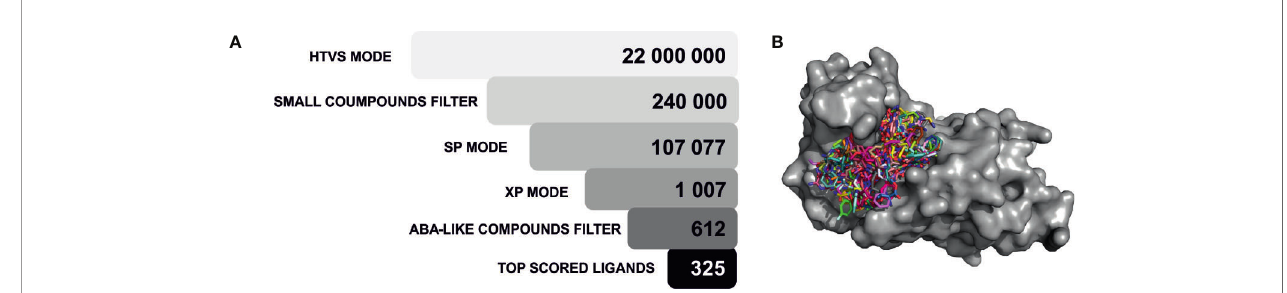
FIGURE 4 | Virtual screening procedure. (A) The 325 top-ranked compounds resulting from the virtual screening procedure on a target ABI1 protein surface are shown. Selected molecules are shown as stick models on the protein surface; (B) The virtual screening procedure is shown as a set of fi ltering procedures, which gradually remove chemical compounds in each step. Initially, 22 million chemical compounds from the ZINC database were considered, and these were ultimately reduced to 325 candidate molecules. A three-step docking algorithm was used with different precision modes (HTVS, SP, XP). Small compounds were removed on the basis of number of atoms and ABA-like molecules were also fi ltered out computationally.